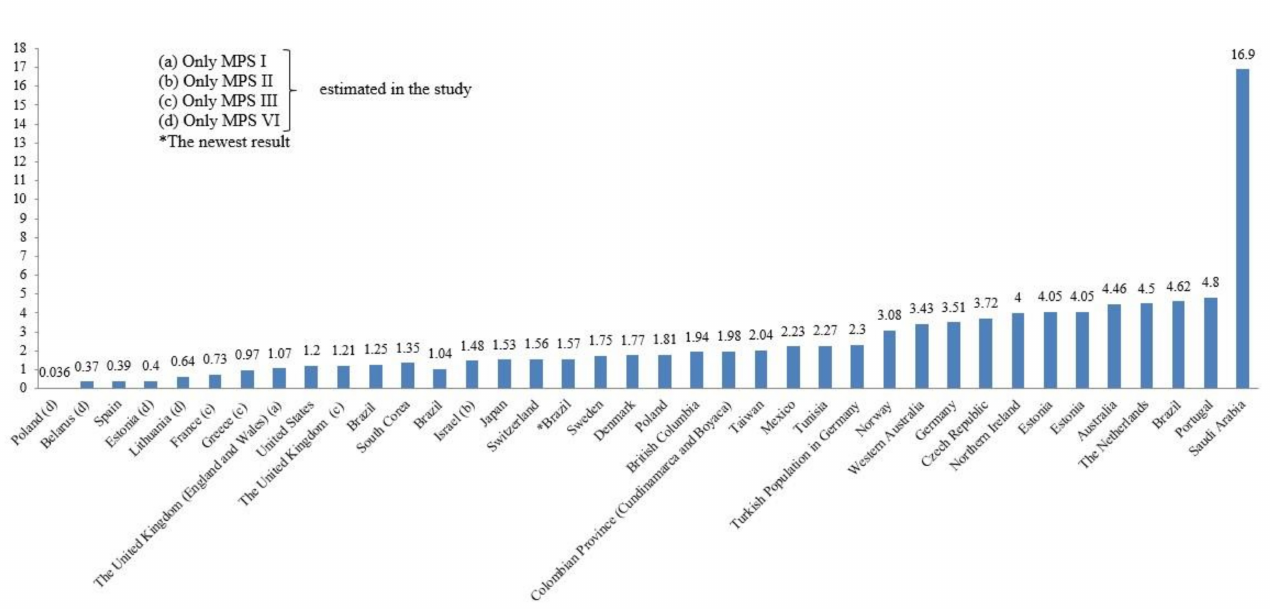
Figure 1. The prevalence of mucopolysaccharidoses per 100,000 live births in 31 countries across the